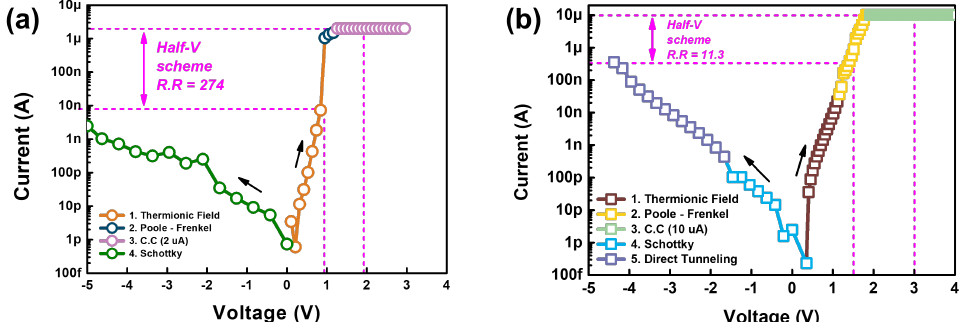
Figure 4. I–V curves of threshold switches at ( a ) 2 µ A and ( b ) 10 µ A current compliance. To analyze the conduction mechanism, the I–V curves are fitted by various conduction mechanisms. In the positive-bias region, the same conduction mechanisms such as thermionic field emission with Poole– Frenkel conduction are observed. In the negative-bias region, only the Schottky emission is observed at the 2 µ A current compliance, while the Schottky emission with direct tunneling is observed at the 10 µ A current